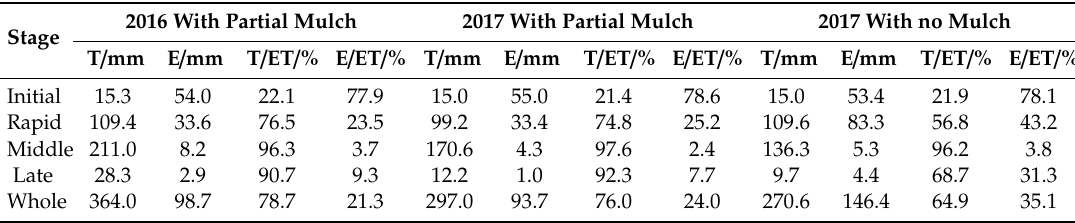
Table 8. Variations in T , E , T / ET , and E / ET of summer maize on partial mulched and non-mulched plots during di ff erent growth periods in Xinjiang,